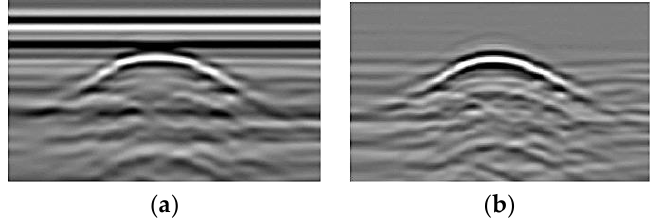
Figure 2. Preprocessing results. ( a ) Original B-scan. ( b ) Preprocessed B-scan.